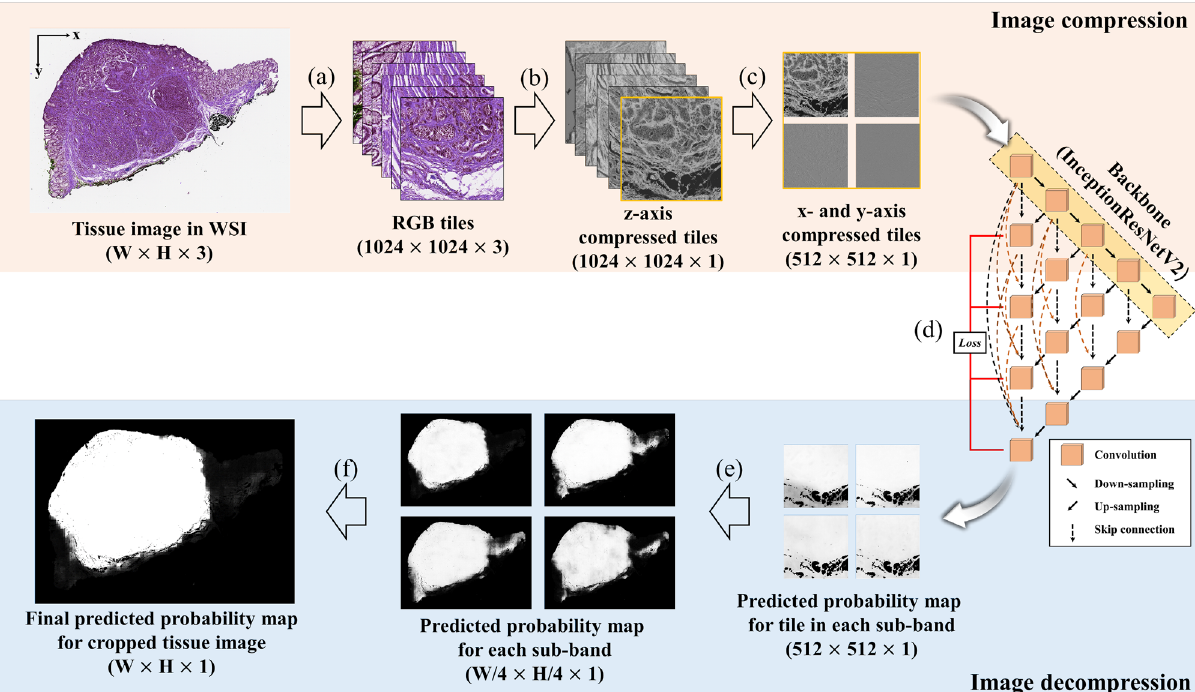
Figure 6. Overall flow chart of the proposed method. ( a ) Tile extraction based on a sliding window. ( b ) Image depth compression. ( c ) Forward transform to the compressed domain. ( d ) Training and prediction using convolutional neural networks. ( e ) Prediction from one tile to the whole image. ( f ) Wavelet-weighted ensemble